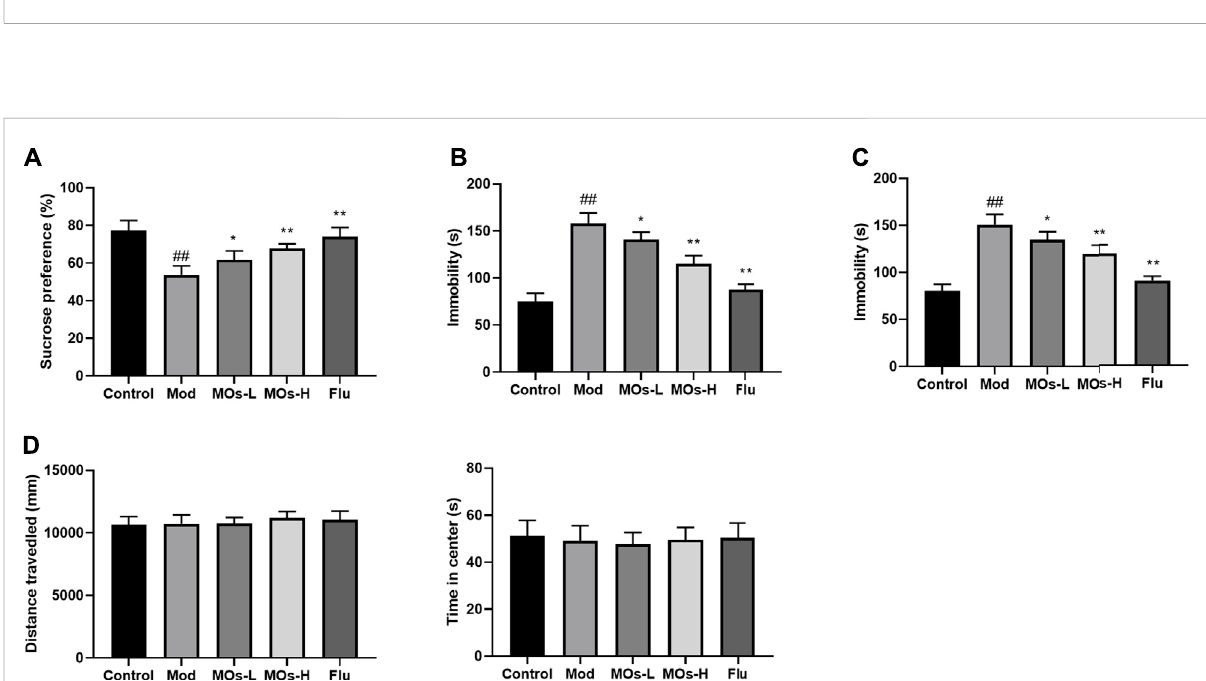
FIGURE 1 Protein expression ofMyD88, p-PI3K, p-AKT and p-NF- κ Bp65inthehippocampus ofCMS-exposedmice. (A) Mice were subjected to theCMS protocol for 4 weeks, then sucrose preference test was performed. (B) Densitometric analysis and representative western blots of MyD88, p-PI3K, p-AKT and p-NF- κ B p65 expressed in the hippocampus. Data are expressed as means ± SD ( n = 3). # p < 0.05; ## p < 0.01.